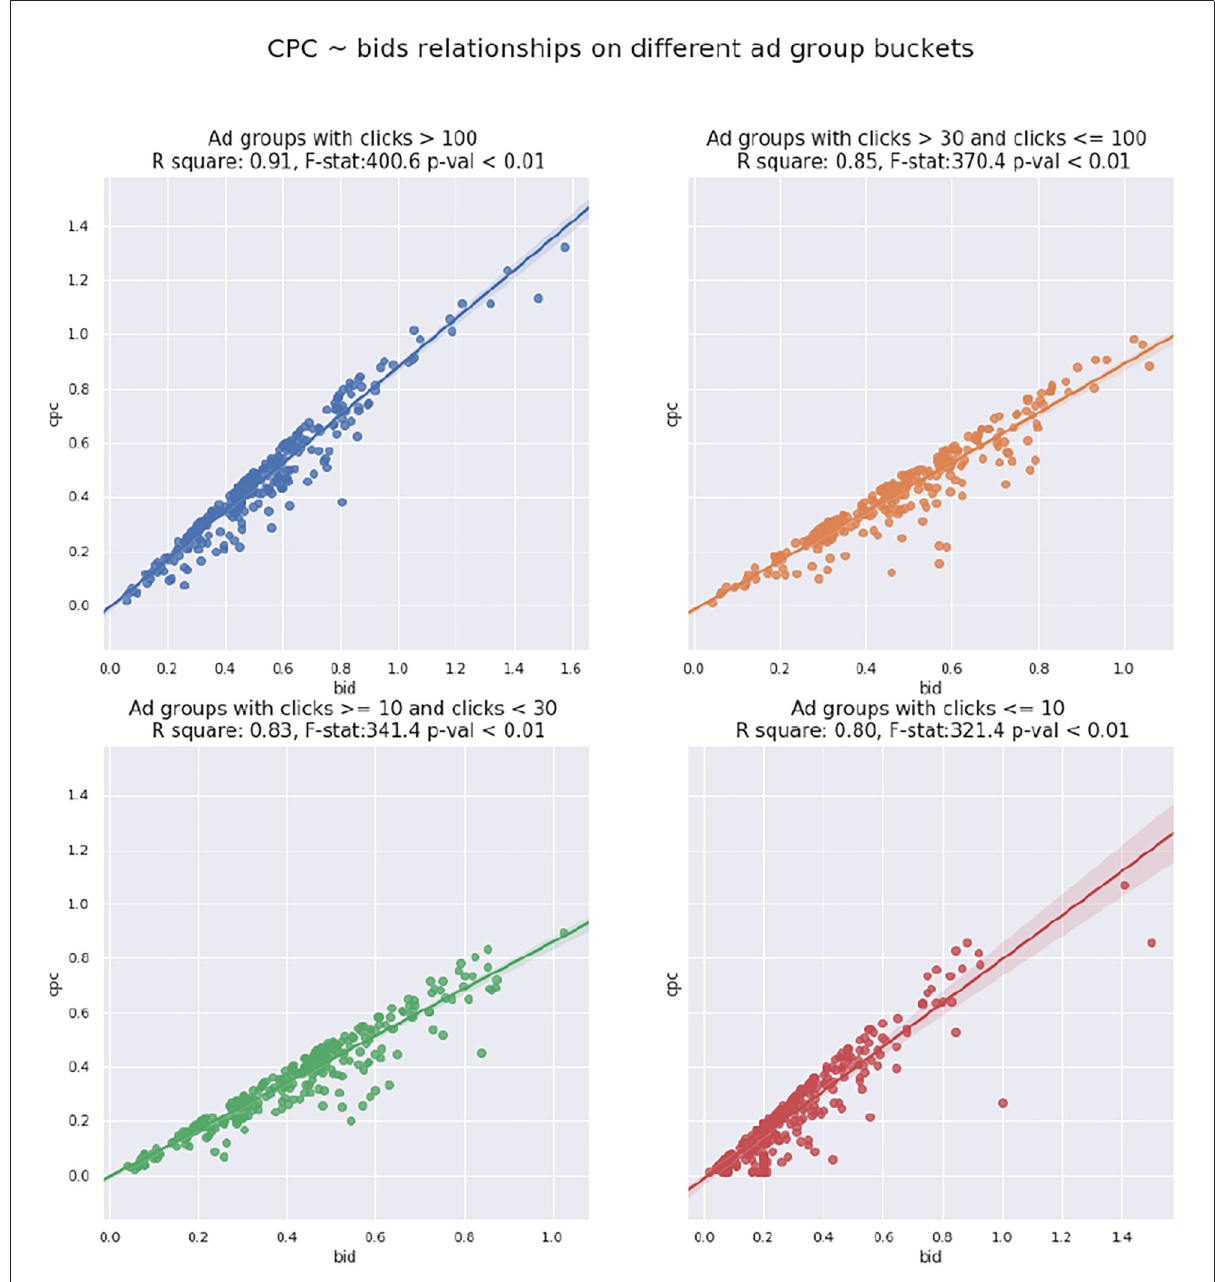
FIGURE5 Cost per click (CPC) bids scatter plot with regression line for different ad group buckets regarding